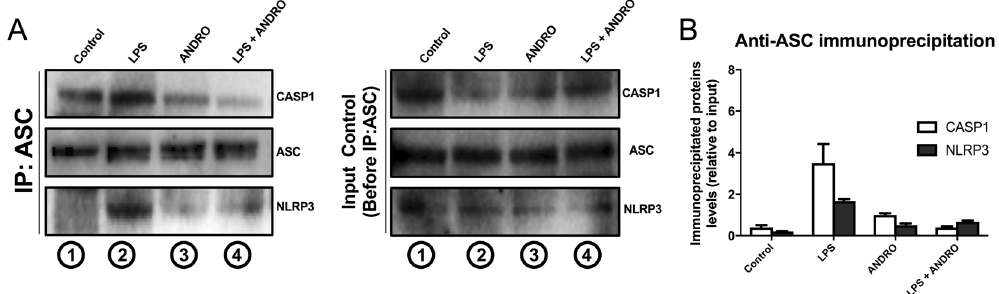
Figure 8. Andrographolide (ANDRO) affects inflammasome assembly in hepatic cells. Fat-laden hepatocytes were treated with LPS for a short period of time (3 h) and then were treated with ANDRO for 1 h. Total proteins were isolated and immunoprecipitated with an antibody against the inflammasome protein Apoptosis- Associated Speck-Like Protein Containing CARD (ASC). ( A ) The immunoprecipitated extract was separated by SDS-PAGE and then blotted and revealed with antibodies anti-Nucleotide-binding oligomerization domain leucine-rich-repeat containing receptor 3 (NLRP3) and Caspase-1 (CASP1) to assess inflammasome assembly (IP:ASC, left panel). CASP1 and NLRP3 immunoprecipitated with ASC in LPS-treated cells (IP:ASC, left panel, lane2) confirming LPS-induced inflammasome assembly. ANDRO treatment interfered with this process (IP:ASC, left panel, lane4). Before the immunoprecipitation assay, the presence of the indicated proteins was determined by western blot of total extracted proteins (Input control blot, right panel). (B) Anti-ASC immunoprecipitated proteins (CASP1 and NLRP3) were quantified and plotted over input protein levels.